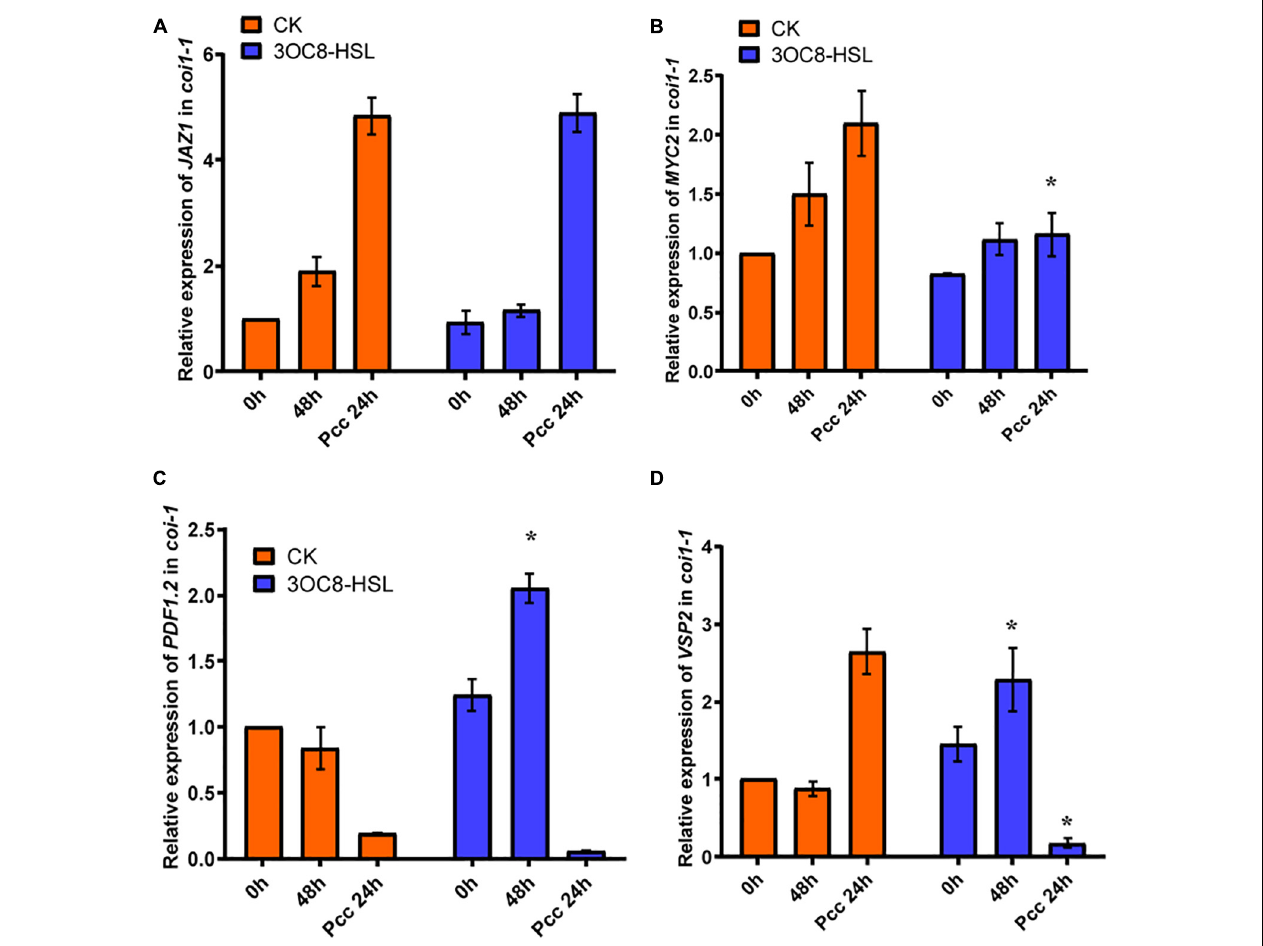
FIGURE 4 | Expressions of JA regulatory genes and response genes in JA pathway mutant coi1-1 . (A) Expression of JAZ1 in coi1-1 after 3OC8-HSL pretreated or not. (B) Expression of MYC2 in coi1-1 after 3OC8-HSL pretreated or not. (C) Expression of PDF1.2 in coi1-1 after 3OC8-HSL pretreated or not. (D) VSP2 in coi1-1 after 3OC8-HSL pretreated or not. At least five independent experiments were performed, each of which with three technical repeats. Asterisks indicate a statistically significant difference between the AHL-pretreated and the water-treated plants (ANOVA test, * P < 0.05). Values are means ± SD of five independent